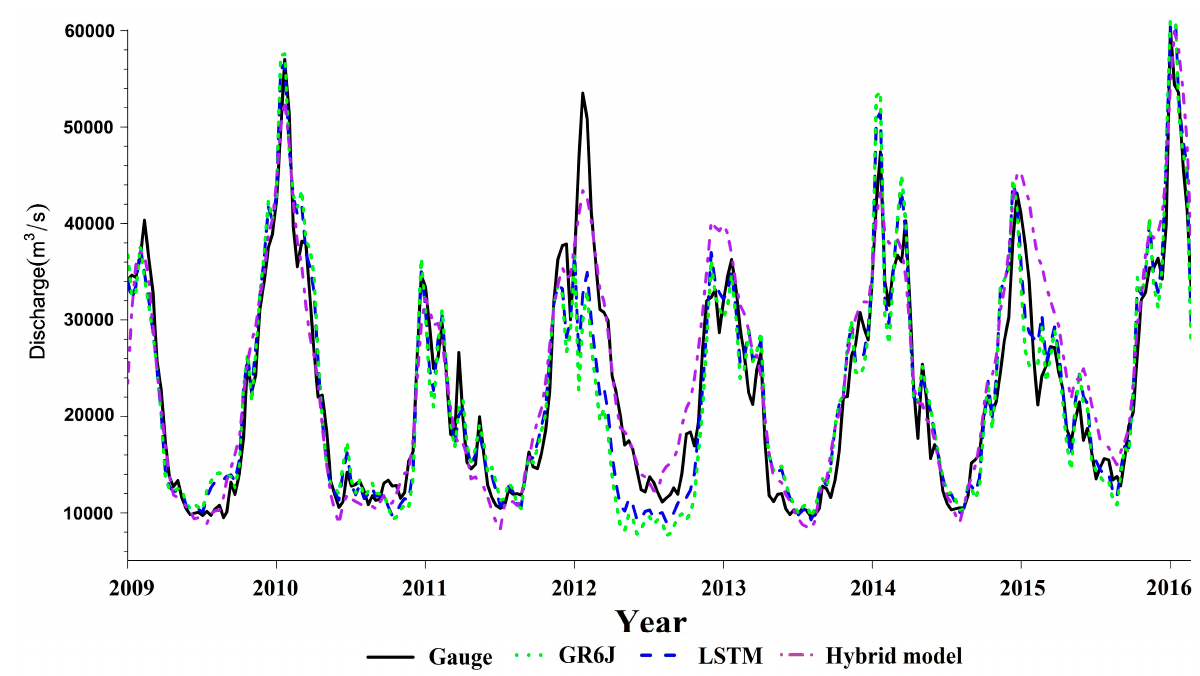
Figure 7. Estimated flow discharges by the GR6J model, LSTM model, and hybrid model at the VS077, and the observed flow discharges at the Huangshigang station between 2009 and 2016.